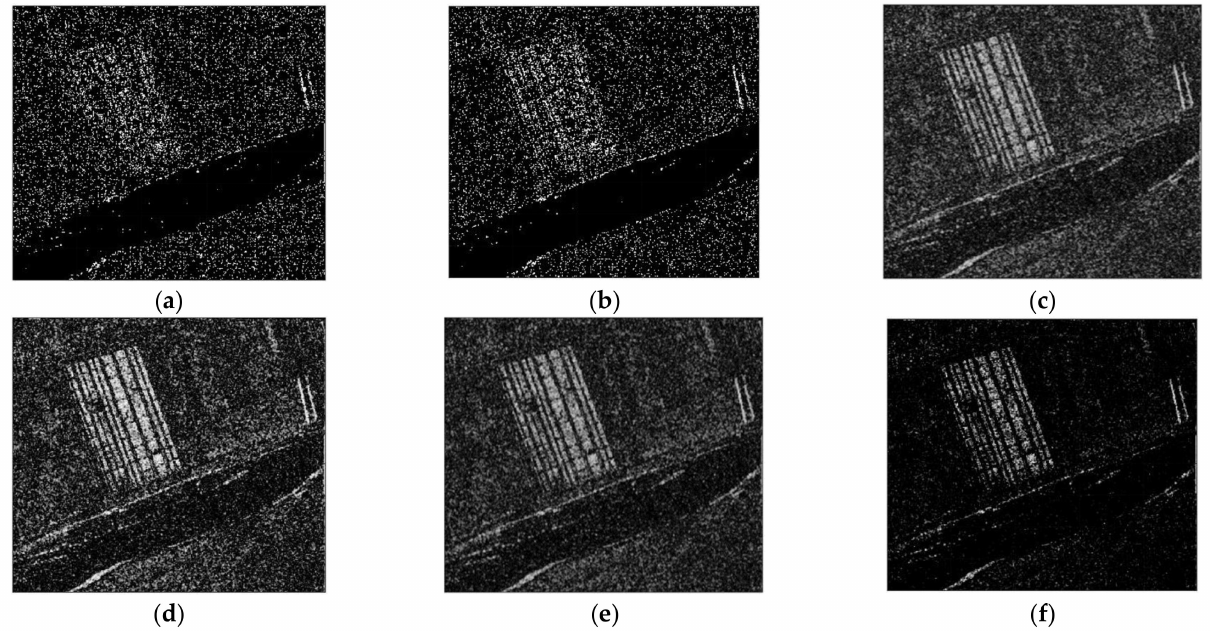
Figure 9. CDMs using dataset 3 obtained by six CD algorithms before median filtering in the post processing step. ( a ) CDM reconstructed by the CC. ( b ) CDM reconstructed by the LMT. ( c ) CDM reconstructed by the NRA. ( d ) CDM reconstructed by the SEST. ( e ) CDM reconstructed by the BGD. ( f ) CDM reconstructed by the proposed method.